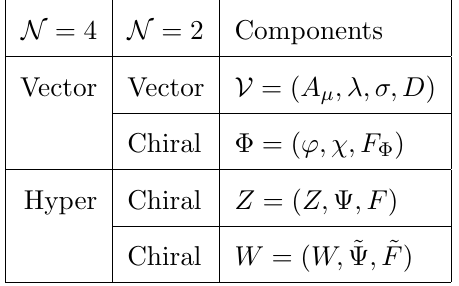
Table 1 . The (cid:12)eld content of